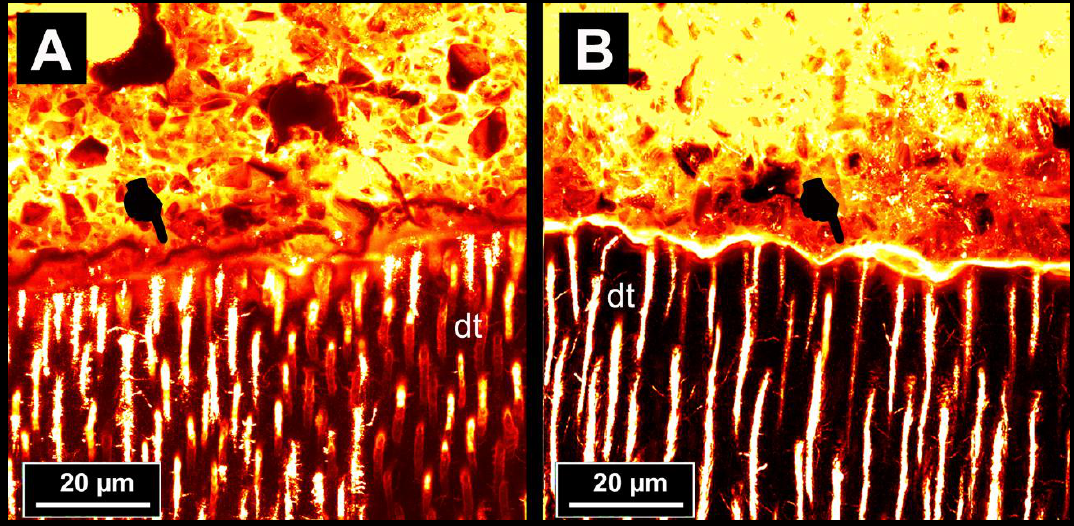
Figure 4. Confocal images of interfaces after cycle load aging and prolonged AS aging. ( A ) A representative CLSM projection of a RMGIC-dentine interface created by applying the RMGIC onto a dentine pre-treated with no PAA and subjected to prolonged AS storage. It is possible to observe the presence of a cohesive fracture within the RMGIC layer (pointer), probably created during specimen preparation (polishing) due to the brittle characteristics of such a material. This observation is supported by the absence of a permeable interfusion layer at RMGIC-dentine interface due to the maturation of the latter after prolonged storage in AS. Conversely, the RMGIC-dentine interface created by applying the RMGIC onto a dentine pre-treated with PAA and then subjected to prolonged AS storage ( B ) shows a remaining thin permeable interdiffusion layer (pointer), which indicates the presence of porosities created subsequent to collagen degradation during prolonged water storage.